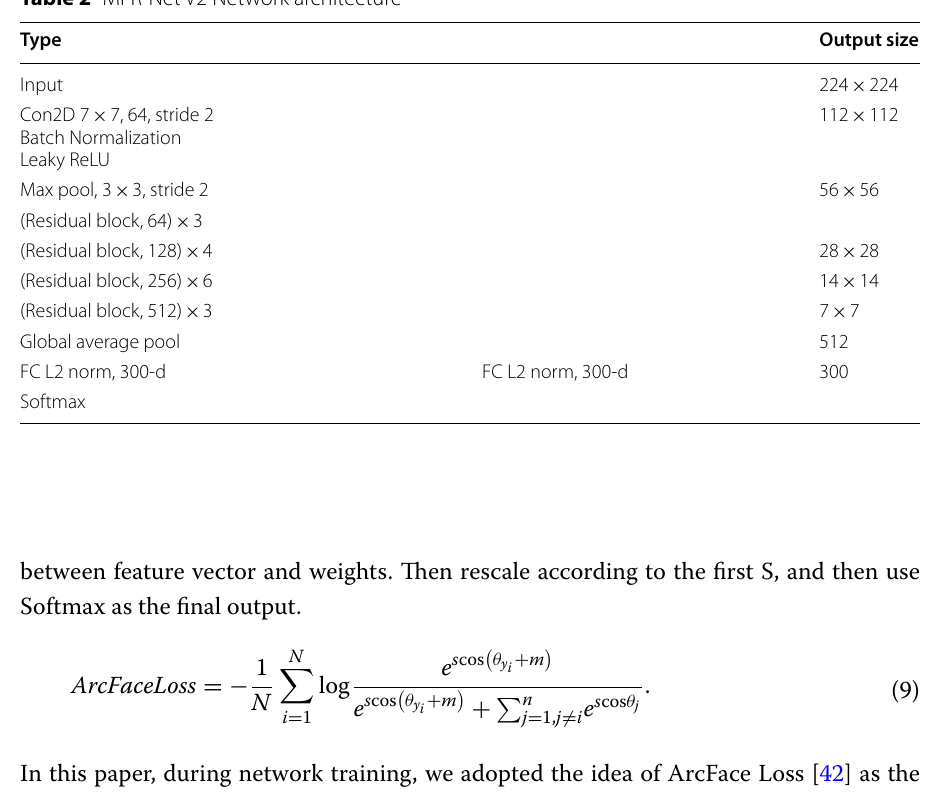
Table 2 MFR‑Net V2 Network